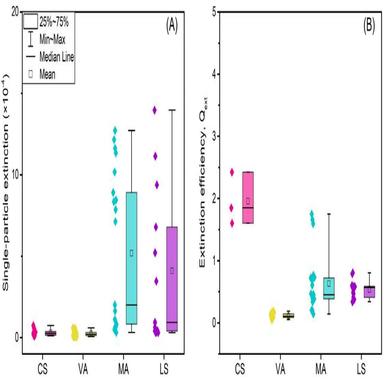
Measured extinctions of the four types of single particles in different sizes. (A) The single-particle extinctions from the same type of particles show the sizedependence; the extinctions from different types of particles also take the material's absorption into account. (B) Extinction efficiencies of different types of single particles reflect the material-dependence of the measured single-particle extinction.